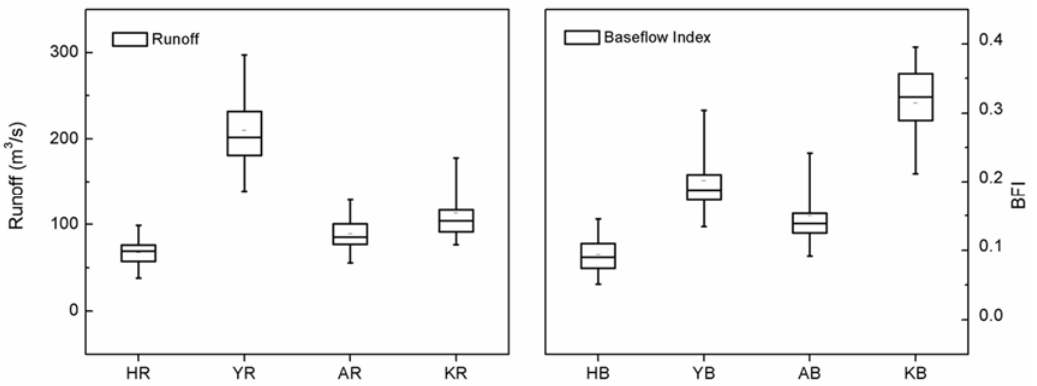
Figure 3. Box plots of spatial variations for runoff and BFI. Data sites were in the Hotan, Yarkand, Aksu, and Kaidu Rivers. The box plot has lines at the lower quartile, median, and upper quartile values. The whiskers of the box are lines extending from each end of the box to show the extent of the rest of the data. The outliers of the box are data with values beyond the ends of the whiskers.